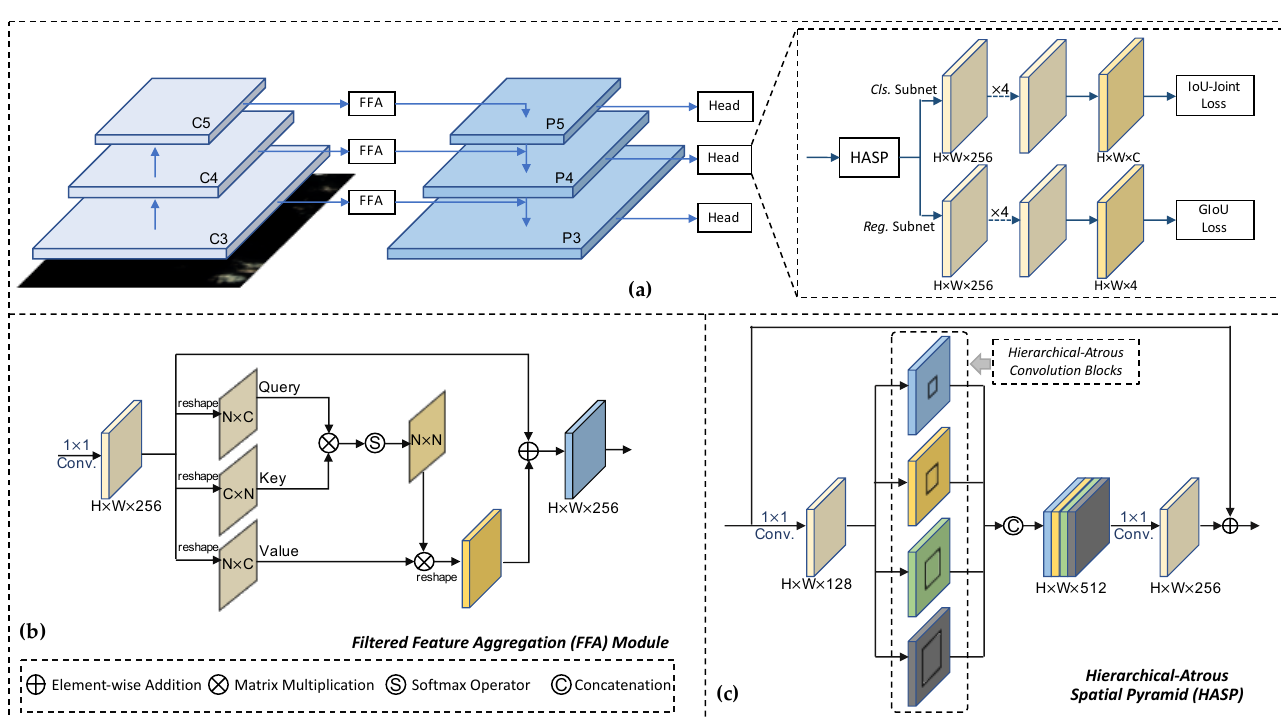
Figure 2. The network architecture of LR-TSDet. It consists of a backbone network, a feature pyramid network (FPN) [33] and multiple detection heads. The filtered feature aggregation (FFA) module is inserted between the backbone and FPN to enhance the capability of the top-down pathway. The detection head is appended to each FPN level, having a hierarchical- atrous spatial pyramid (HASP) and two subnets for object classification and box regression. ( a ) The pipeline of the network. ( b ) Filter Feature Aggregation (FFA) Module. ( c ) Hierarchical-Atrous Spatial Pyramid